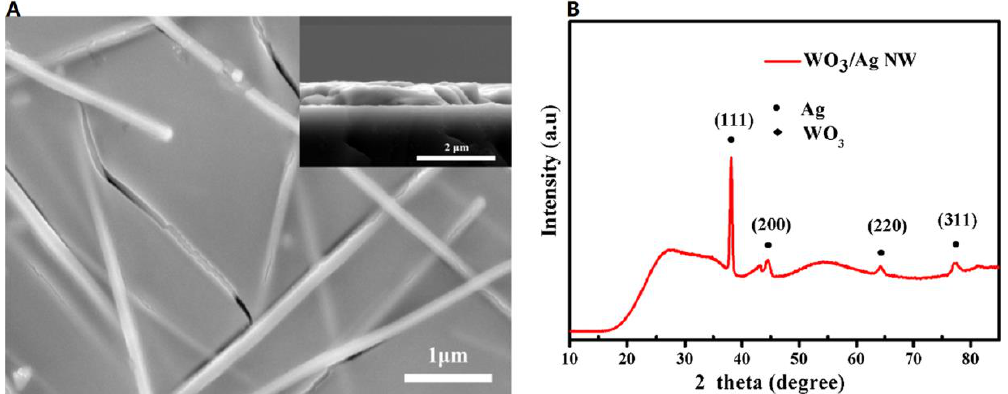
Figure 21. ( A ) SEM image of the AgNW electrode coated with WO 3 film and the cross-section of the WO 3 /AgNW (inset) and ( B ) XRD pattern of the WO 3 /AgNW film [92].